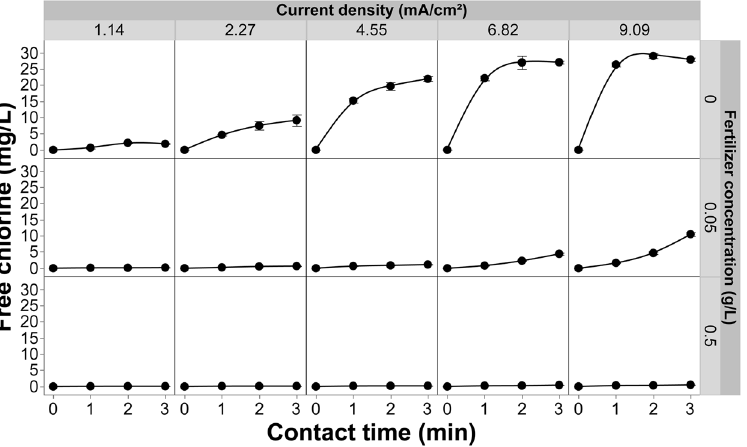
Figure 7. Effluent free chlorine measured from the EFC as a function of current density, contact time, as well as varying the concentration of fertilizer in solution. All of these experiments were conducted with a chloride concentration of 20 mg/L. Error bars are ± SEM, N = 3. Where error bars are not shown they are too small to be visible behind the symbol.